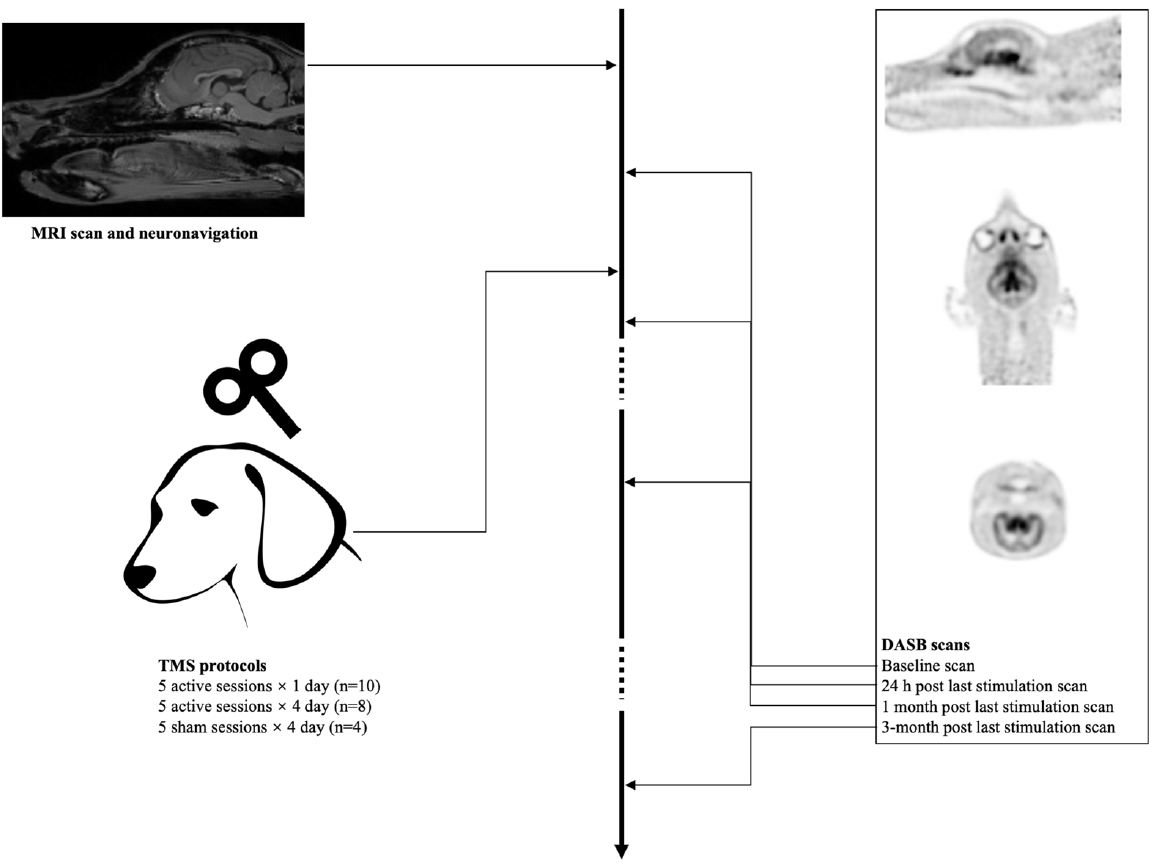
Figure 1. Image procedure.